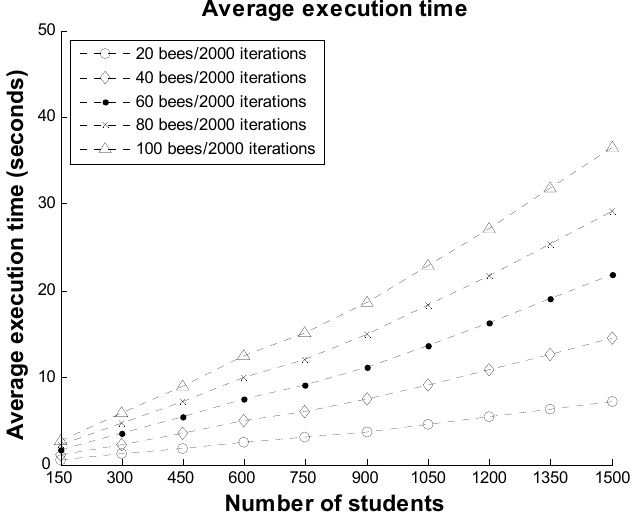
Figure 9. Average execution time values with 2,000 iterations and different numbers of